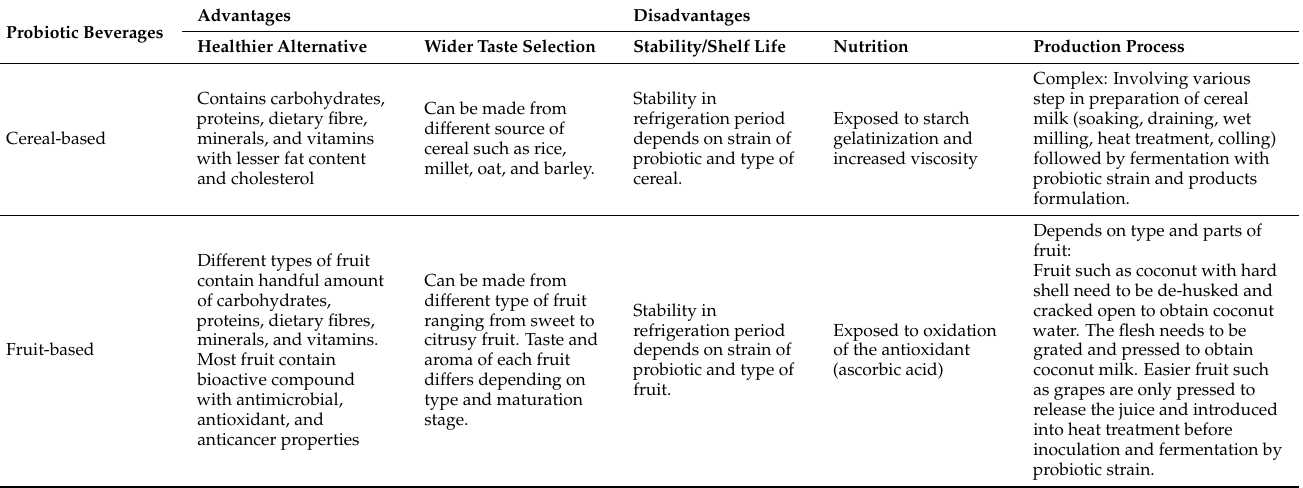
Table 3. Advantages and disadvantages of cereal and fruit-based probiotic